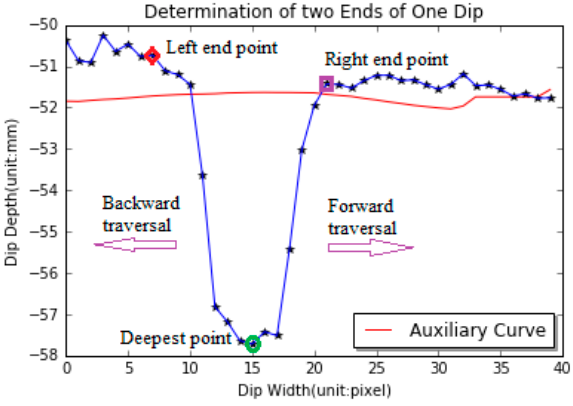
Figure 6. Diagram of determination of two endpoints of a dip.